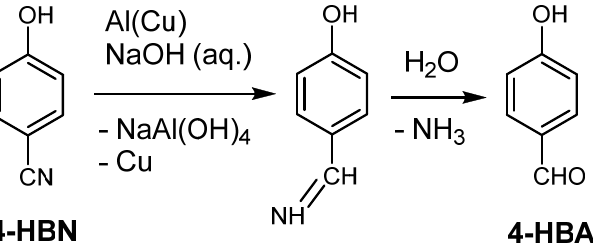
Figure 1. Kinetics of the HDB of BRX (5 mM) in 100 mM aq. NaOH using Dev. alloy (3 g/L). In addition, the percentage of soluble part of Al from original Dev. alloy is supplemented.